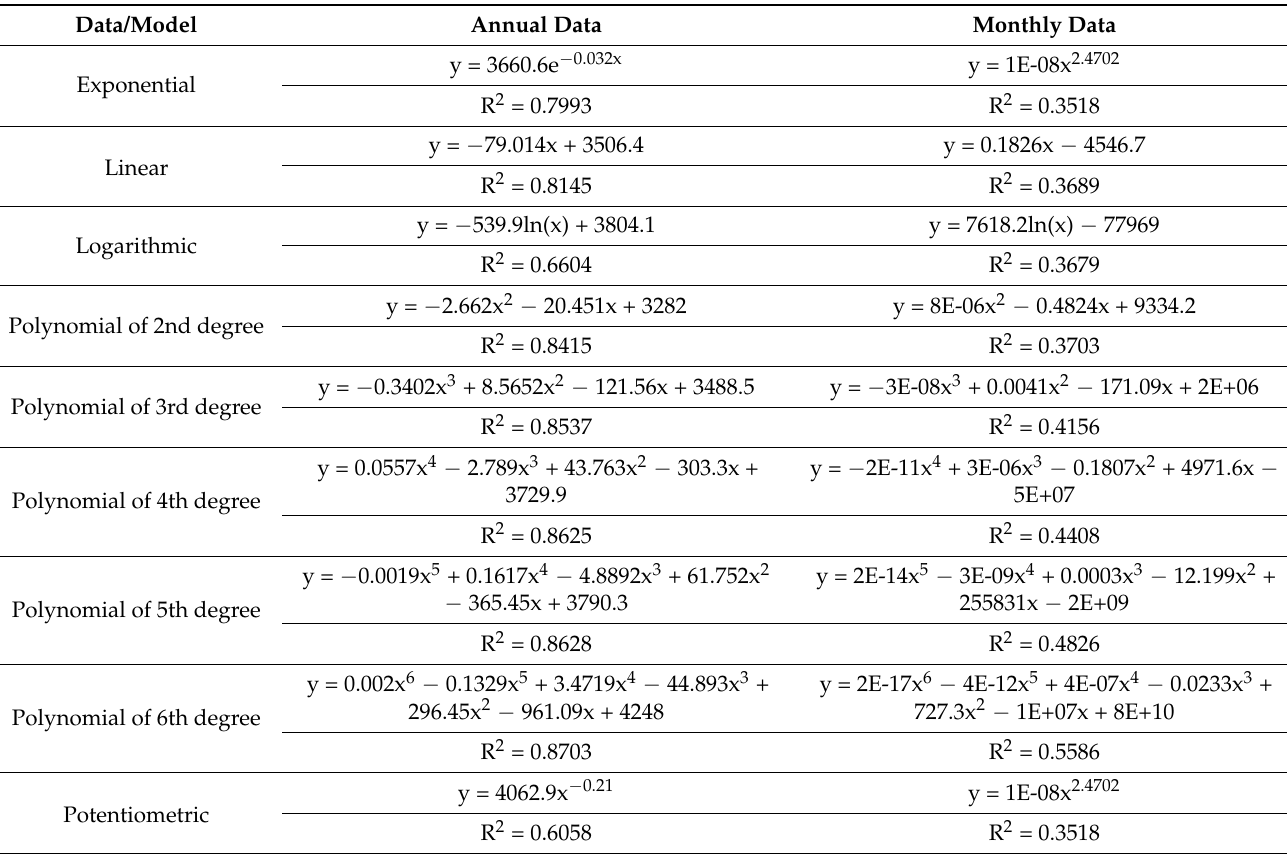
Table A1. Trend models for the Lower Silesian